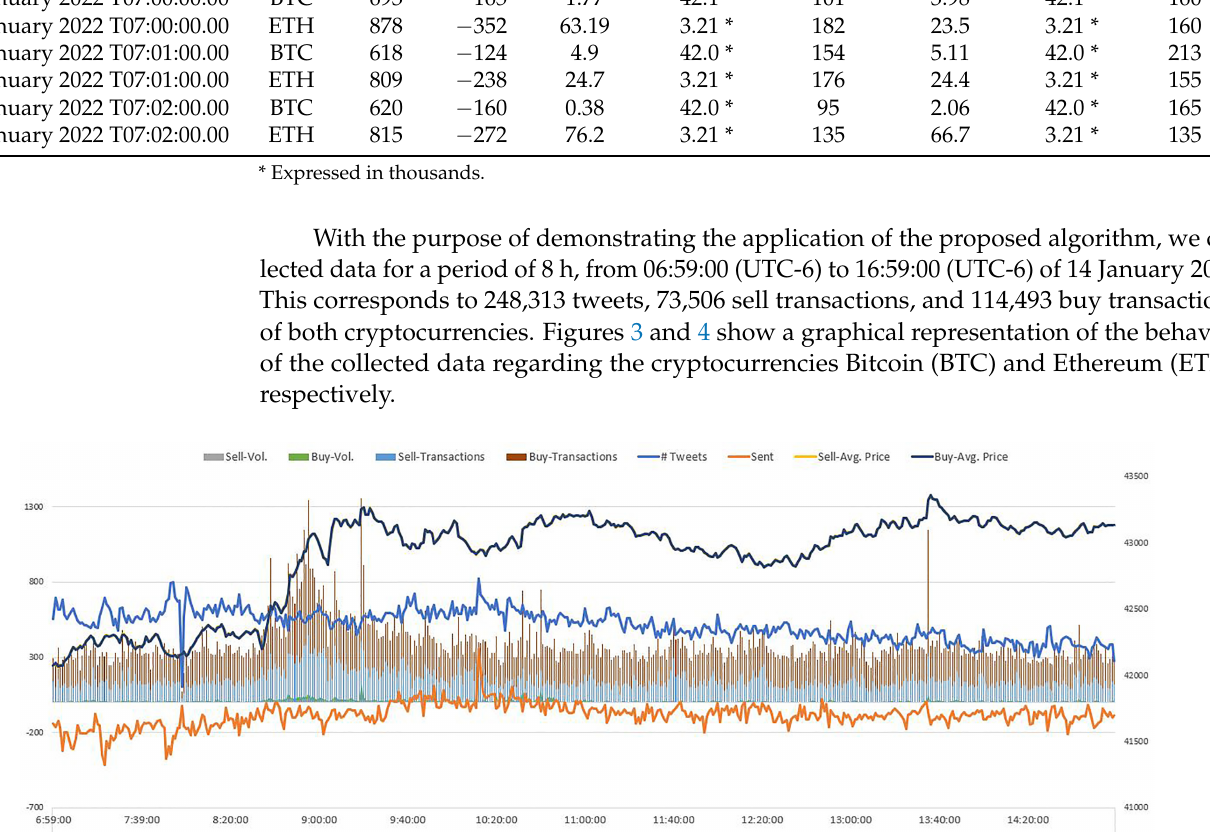
Figure 3. Graphical representation of data related to cryptocurrency Bitcoin (BTC). Source: compiled by